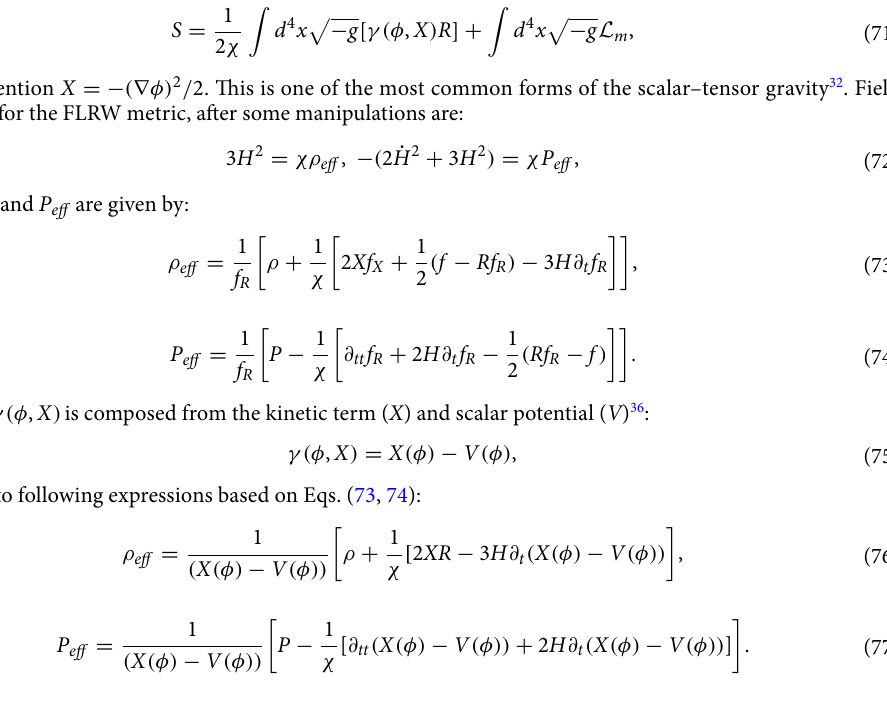
0.25 0.5 and C 3 = − = −